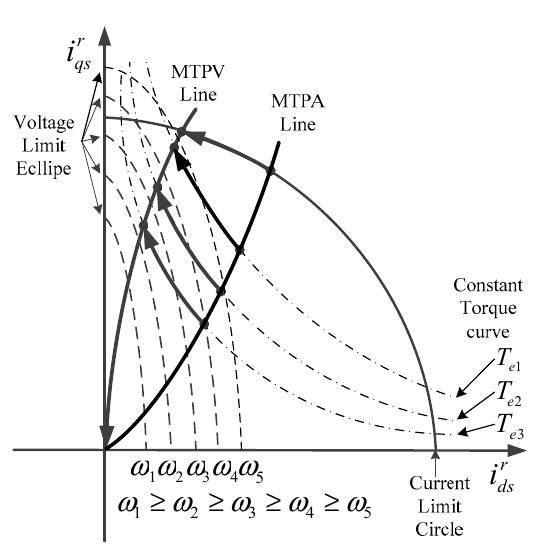
Figure 1. Synchronous reluctance motor (SynRM) current trajectories.